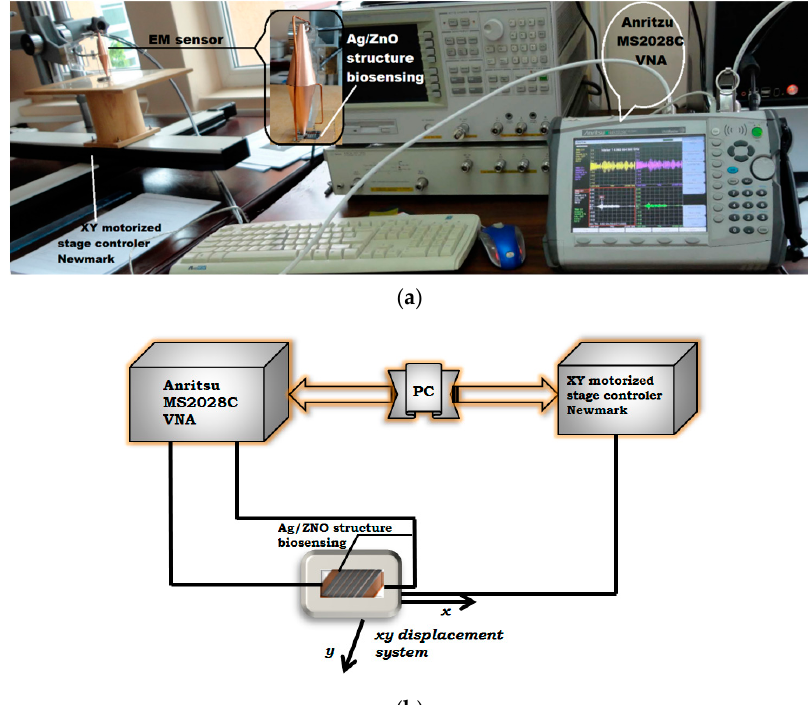
Figure 6. ( a ) experimental set-up; ( b ) block scheme. During the measurements, the transducer is fixed and the samples are displaced in front of the transducer using an XY motorized stage, Newmark type, with the scanning step being 0.1 mm. The EM sensor with metamaterial lenses is connected to an Anritsu MS2028C VNA (Figure 6a), in the interval 850 MHz–900 MHz at 6 equidistant frequencies, with the optimal frequency of 874 MHz being confirmed. The distance between the screen with circular aperture and the surface to be examined (lift-off) is 20 ± 1 µ m. Figure 7b shows that the dependency of the e.m.f. amplitude induced in the reception coil of the sensor correctly emphasizes the extremely thick conductive strips and eventual interruptions. The realized samples were deposited on different substrates, without and with enzymes, and were fixed on a support on a system that assures XY displacement—Newmark USA, controlled by PC through codes written in Matlab 2019b. The distance between the screen aperture and the surface to be examined was maintained at 20 µ m ± 1 µ m [16,36]. By simulation, a field snapshot was obtained in each sequence of geometry. The evanescent waves are emphasized in the plane XY, due to the scattering of the field on the edge of strips.